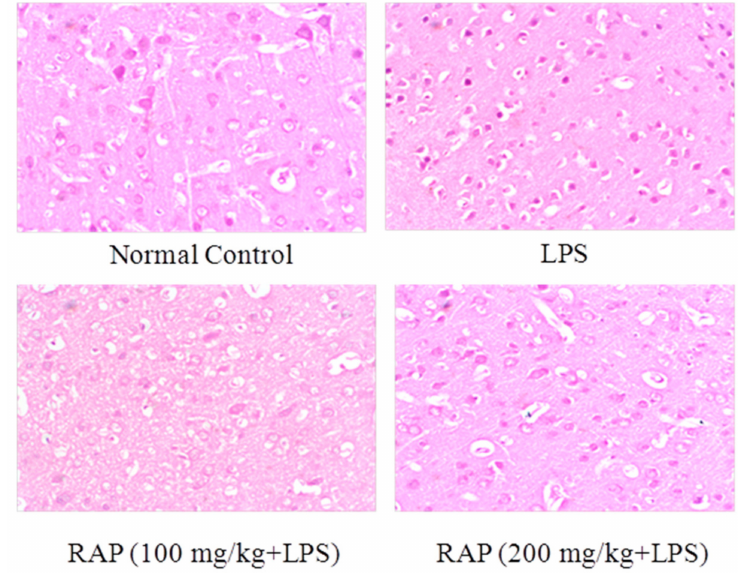
Figure 7. E ff ect of RAP (100 and 200 mg / kg) on histological alterations in the brain of LPS-induced systemic inflammation. There is a severe loss of intact cells in the cortical region of the brain. LPS group shows more vacuolated and edematous tissue in comparison to the normal control group. RAP administration has shown a decrease in neuronal loss. The normal control group has shown the normal morphology of the cortical